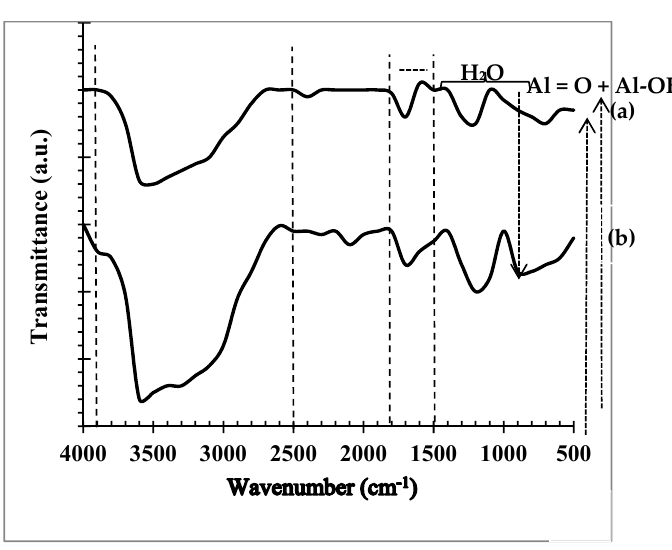
Figure 3. IR spectra of boehmite ( a ) and γ –Al 2 O 3 calcined at 550 °C ( b )